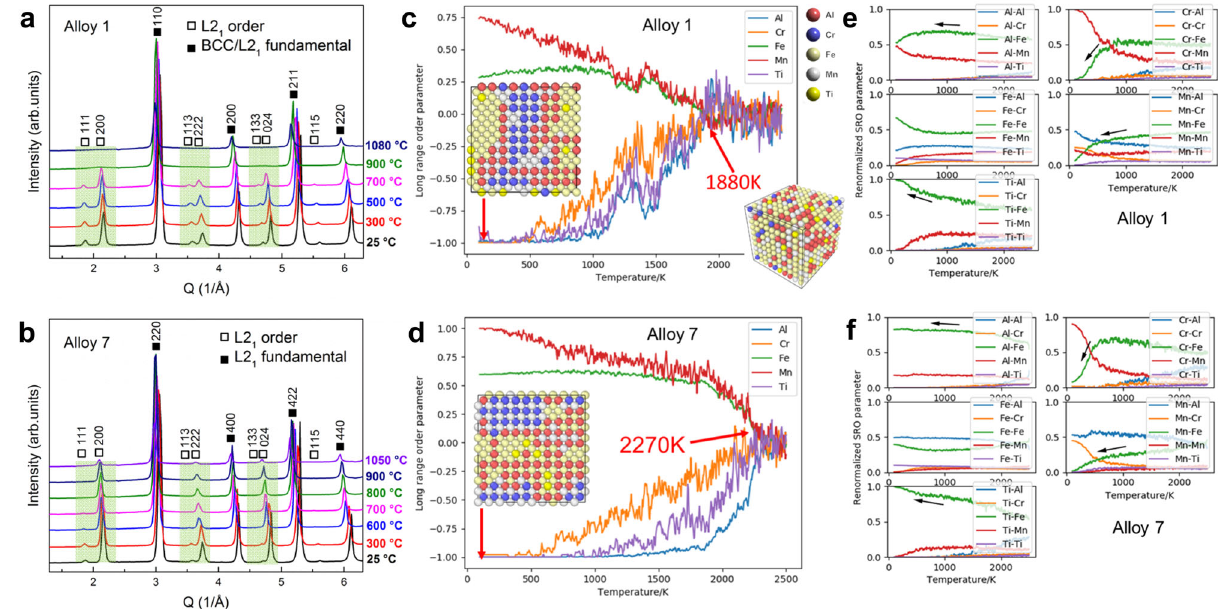
Fig. 4 Order-disorder transitions of Alloys 1 and 7. a , b In situ neutron-scattering patterns of Alloys 1 (Al 20 Cr 5 Fe 50 Mn 20 Ti 5 ) and 7 (Al 30 Cr 5 Fe 50 Mn 10 Ti 5 ) at elevated temperatures, respectively. The label of order means that the re fl ections are exclusive to the L2 1 structure, while the label of fundamental means that the re fl ections are common to both the ordered L2 1 and disordered BCC structures. c , d The MC-calculated LRO parameters as a function of temperature in Alloys 1 and 7, respectively. e , f The MC-calculated SRO parameters as a function of temperature in Alloys 1 and 7, respectively. The black arrows indicate the change of the most abundant, Fe, as the neighbor of all